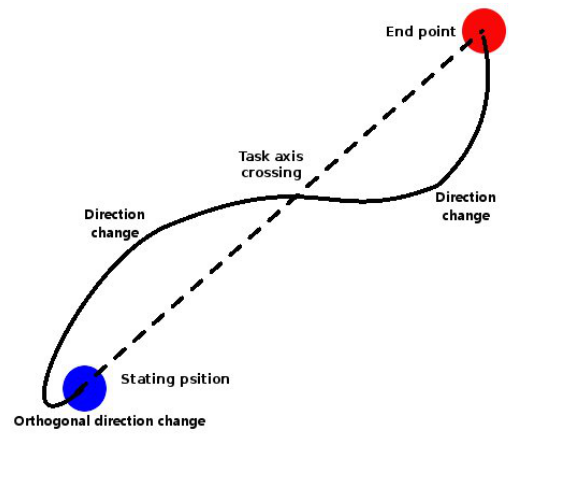
Figure 5. Example of a mouse trajectory to illustrate differences between three movement change metrics with task axis drawn in a dashed